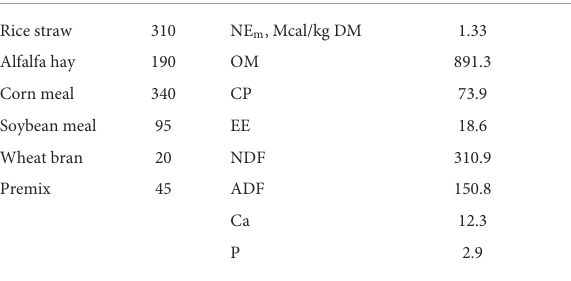
TABLE 1 Components and nutritional composition of the basal TMR